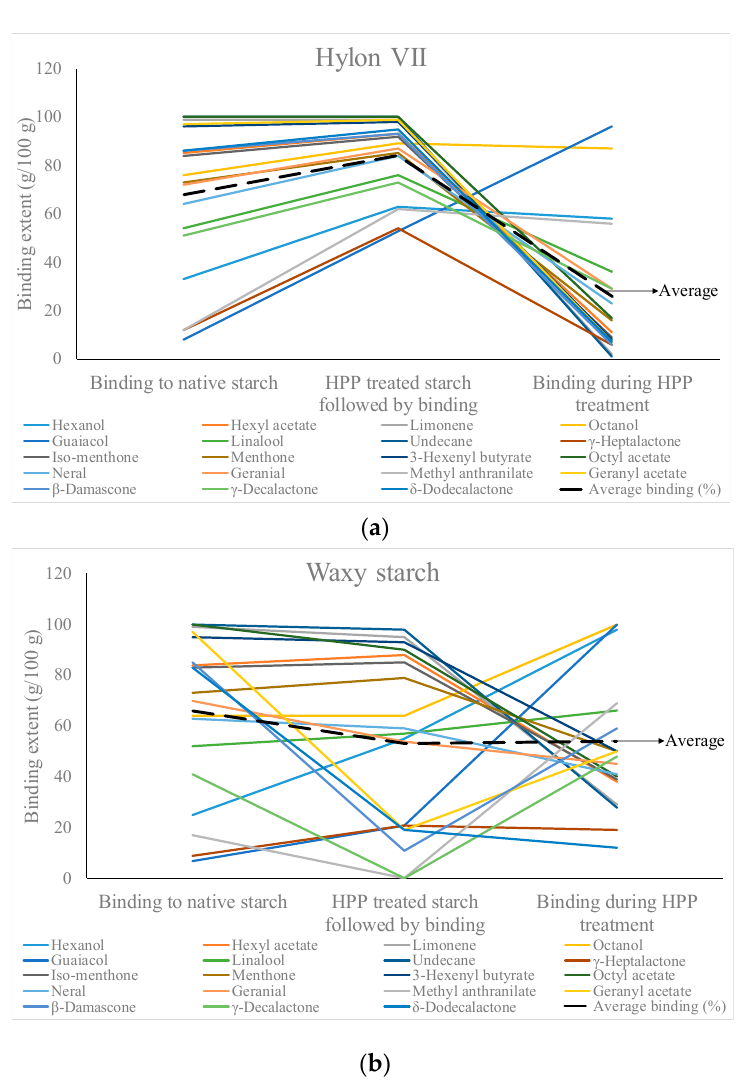
Figure 10. Comparison of binding properties of different odorants to ( a ) high amylose maize starch (Hylon VII), ( b ) no amylose maize starch (waxy starch) treated in various ways (plotted using the data from B ł aszczak, Misharina, Yuryev, and Fornal, 2007 [58]).